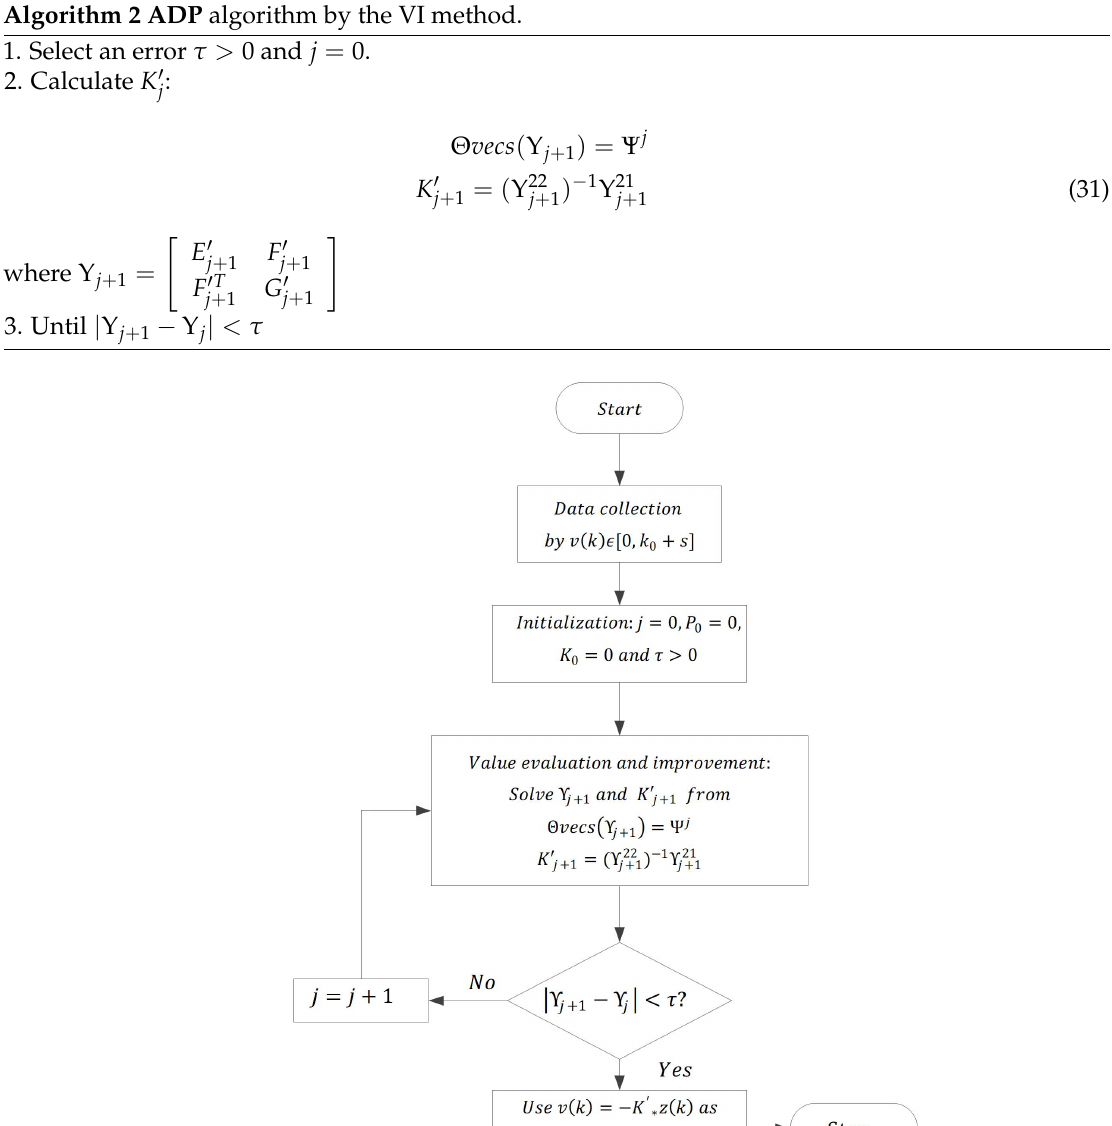
Algorithm 2 ADP algorithm by the VI method.